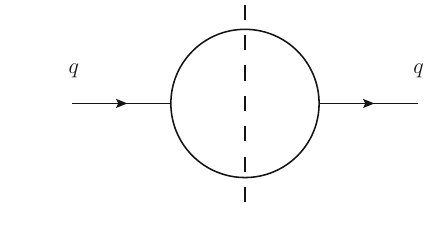
Fig. 2 A two point one loop diagram